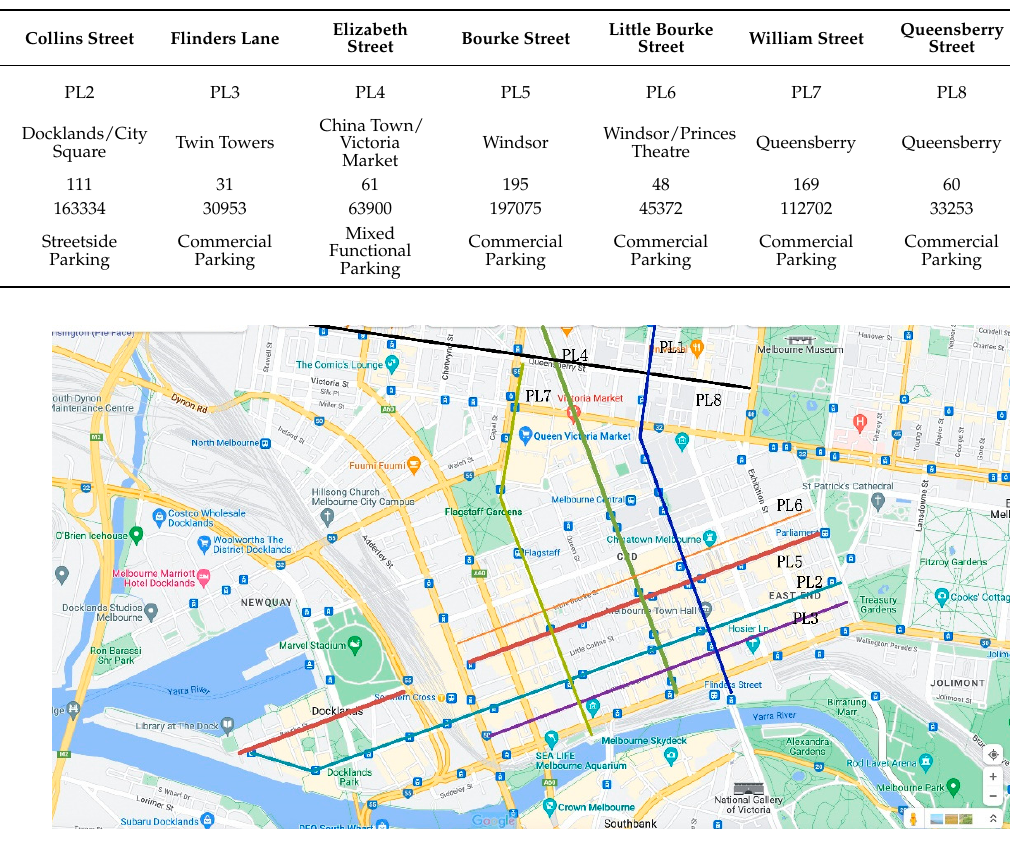
Table 1. The basic information of the eight parking lots.